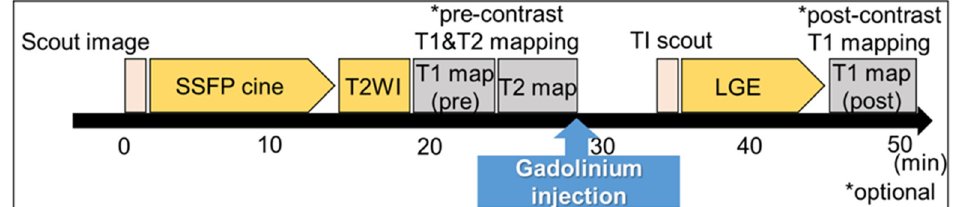
Figure 4. Typical time schedule of a CMR scan. Scout scans of the transaxial, coronal, and sagittal images were acquired. ECG-gated imaging is performed as follows: steady-state free precession (SSFP) short-axis and long-axis cine images are acquired during a breath-hold. T1 mapping images, which are optional, are obtained pre- and post-contrast administration. T2 mapping images are also optional. Late gadolinium enhancement (LGE) images are obtained from post-contrast images with an inversion time chosen to null normal myocardium. High-resolution gradient echo inversion recovery 10 min post-contrast.